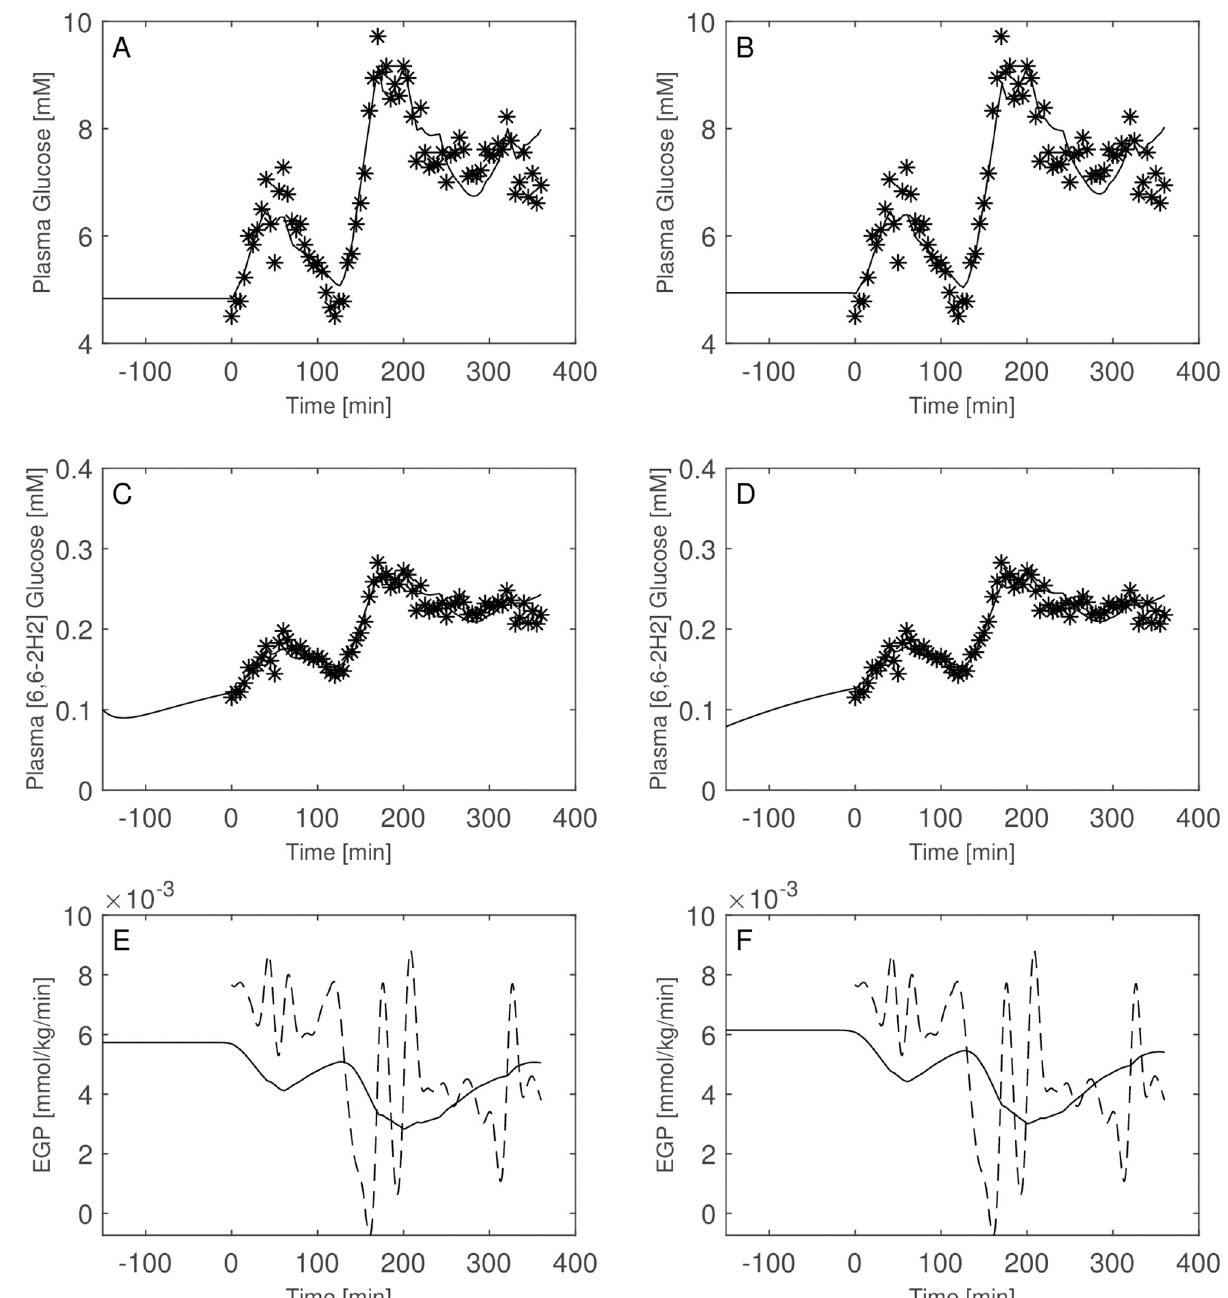
Fig 12. Model comparison for Subject 4. Observed (asterisks) and predicted (line) variables over time with glucose two-compartment model (Panels A, C, E) and one-compartments-glucose model (Panels B, D, F). Dashed line is the predicted EGP with the Steele model. All the observed points refer to data measured on day 2. Plasma glucose concentrations (panel A) are derived from the glucose intra-venous infusion to match plasma glucose observations from the OGTTs of day 1.